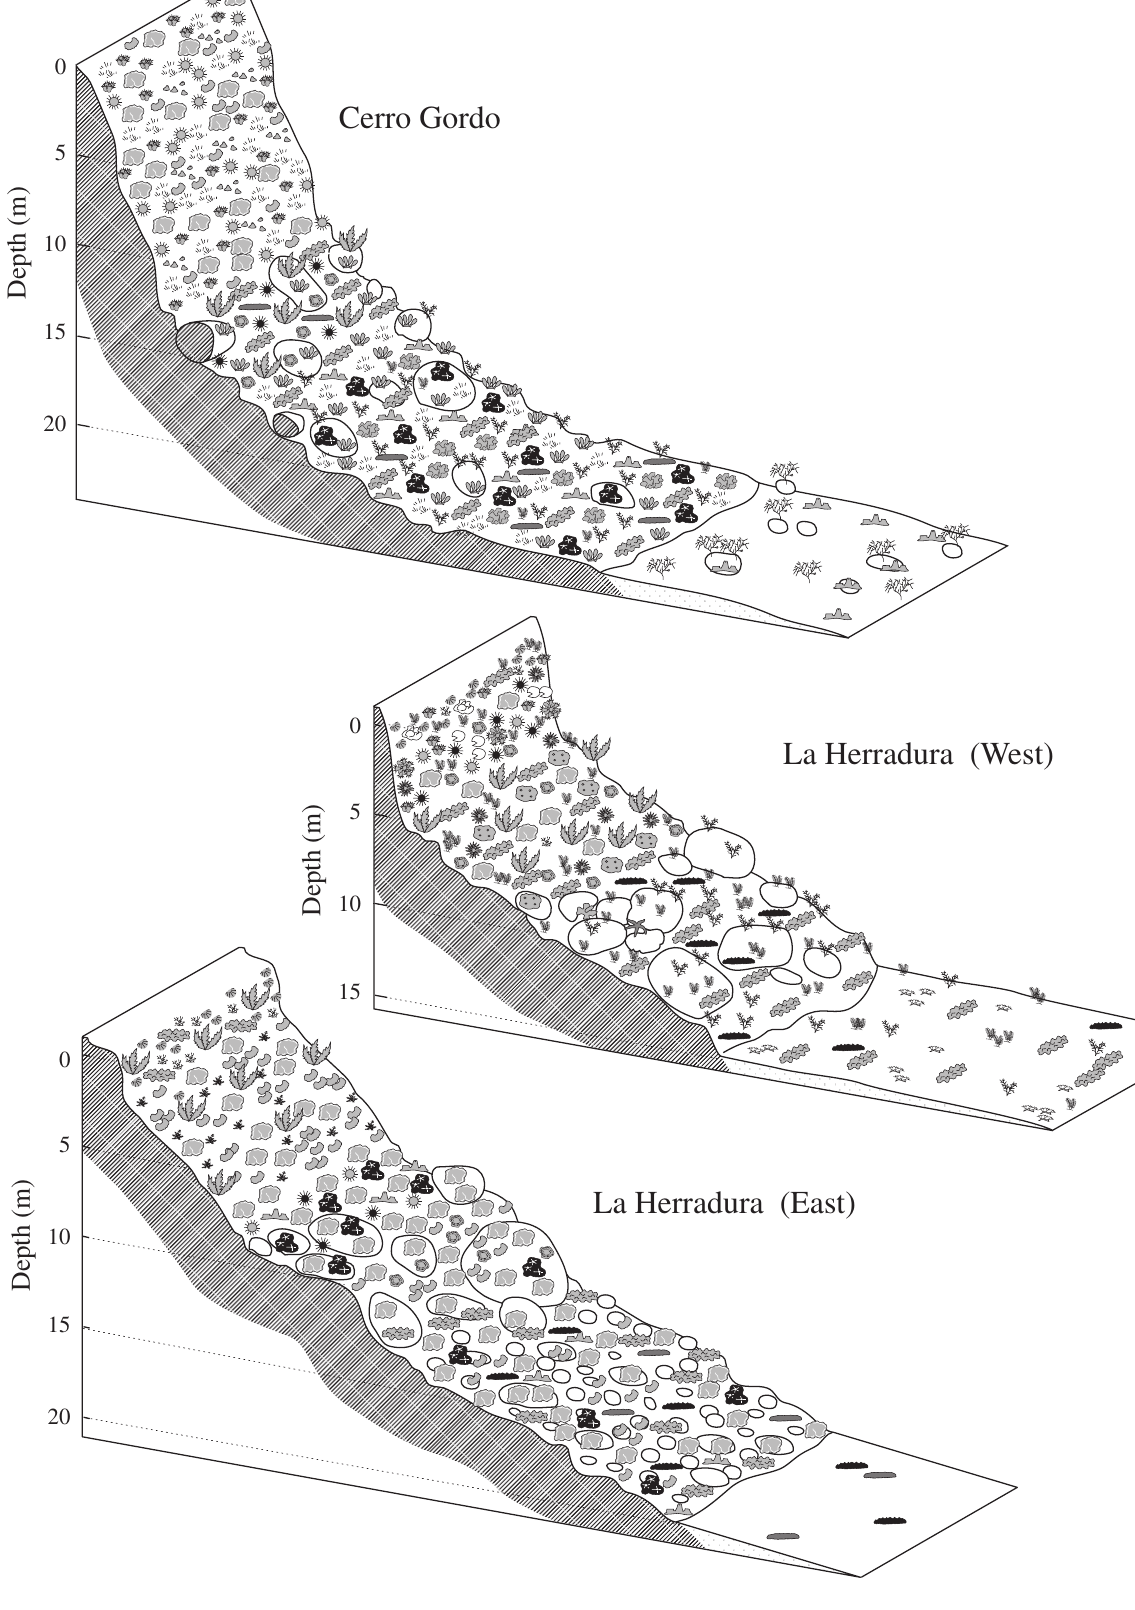
F IG . 2. – Diagrammatic representation of rocky bottom transects: Cerro Gordo (CG), La Herradura-East (HE), La Herradura-West